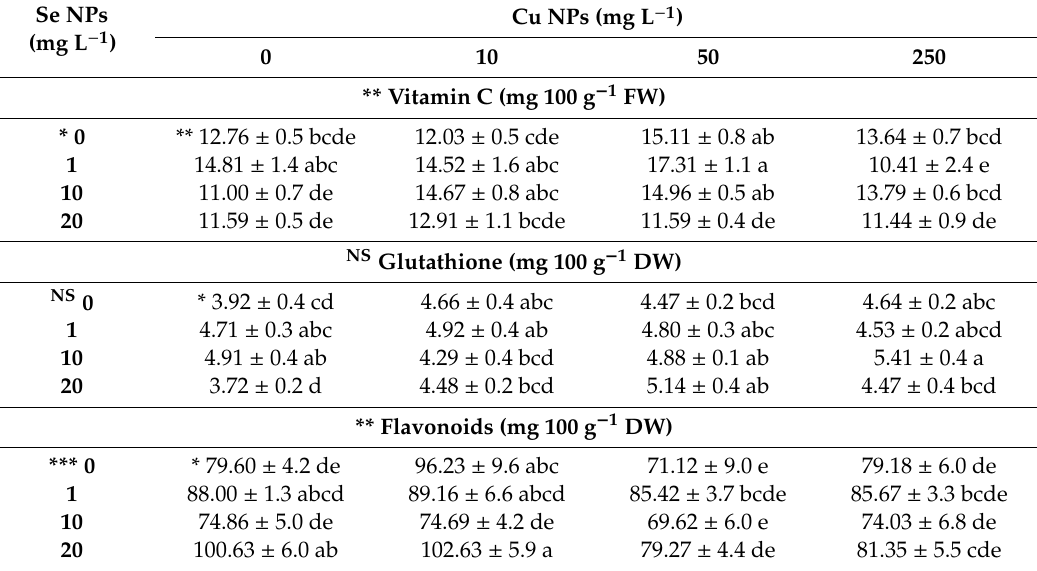
Table 6. Non-enzymatic antioxidant compounds in tomato fruits obtained from plants treated with Se and Cu